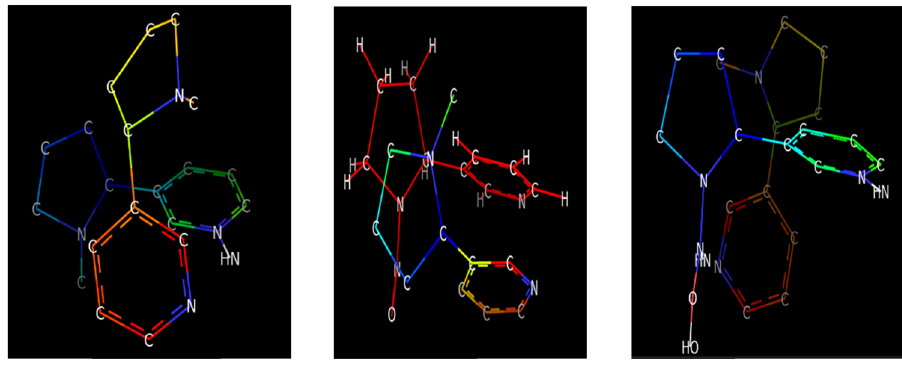
Figure 8: Docking results of three compounds ( Nicotine, NNK, and NNA ) with the ligand showing RMSD and binding a ffi